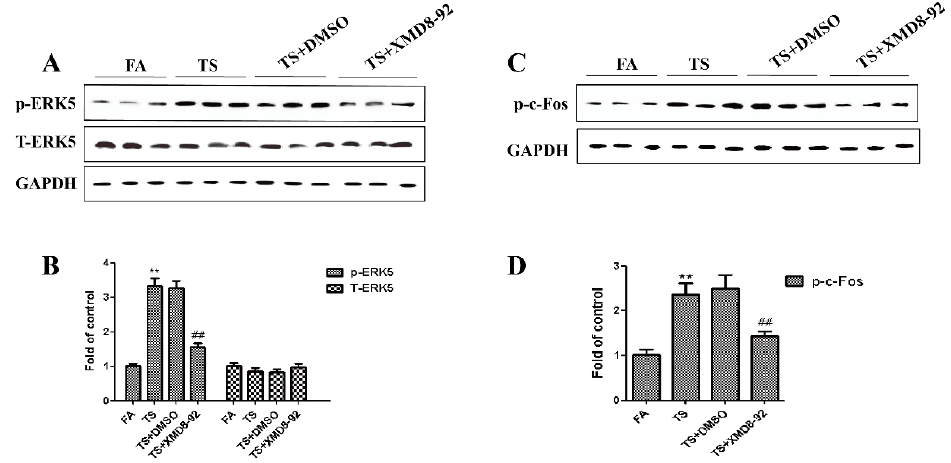
Figure 3. Tobacco smoke-induced ERK5 activation was attenuated by XMD8-92 in the stomach of mice. ( A ) Western blotting analyses of phosphorylated ERK5 and total ERK5; ( B ) Densitometric analyses of Western blotting; ( C ) Western blotting analyses of phosphorylated c-Fos, phosphorylated c-Jun; ( D ) Densitometric analyses of Western blotting. Data are expressed as mean ˘ SD. ** p < 0.01, compared with control; ## FA = filtered air; TS = tobacco smoke.